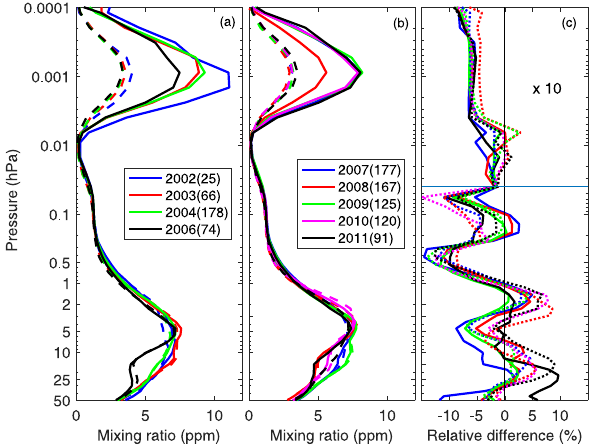
Figure 1. Ozone yearly median mixing ratio profiles and median relative differences from GOMOS Sirius occultations and from paired WACCM profiles from 2002 to 2011 in the 40–60 ◦ S lat- itude band. Occultations take place during late August to mid- September. The vertical axis is pressure. (a, b) GOMOS profiles (solid lines) and WACCM profiles (dashed lines). The colour cod- ing in the legend shows the measurement year and the number of measurements is in parentheses. (c) Relative median difference WACCM–GOMOS/median(GOMOS). Above 0.04hPa differences are divided by 10. The colour coding for (c) follows (a, b) , but 2007–2011 lines are